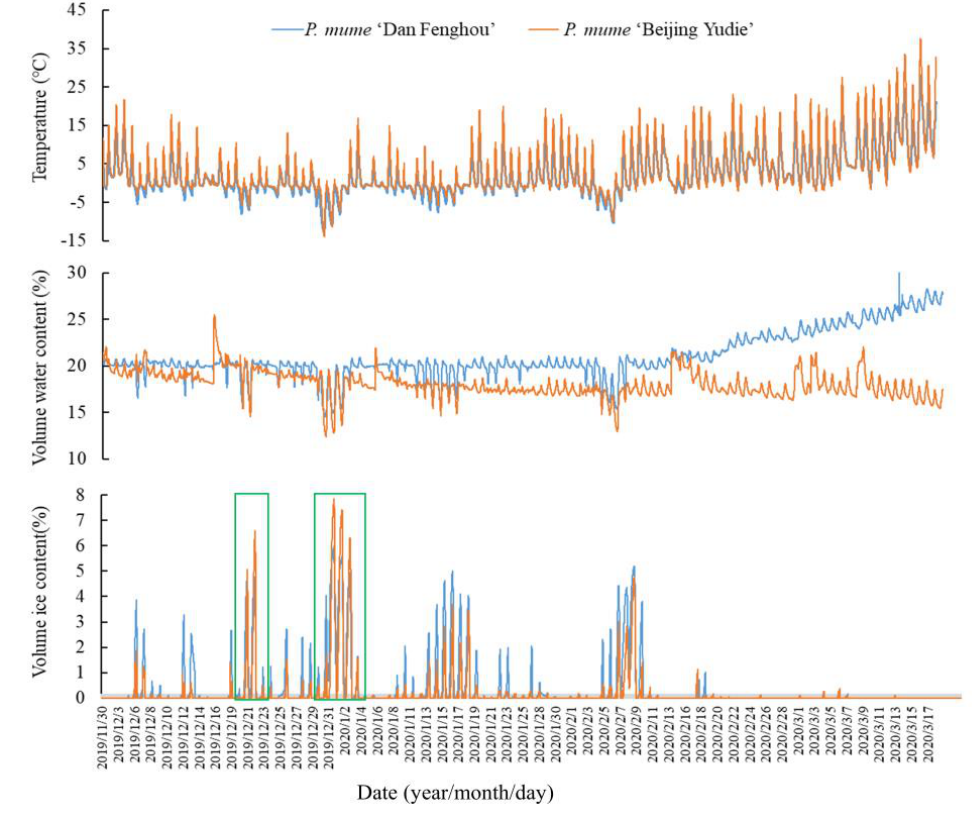
Figure 2. Dynamic monitoring of temperature, moisture content, and ice conditions during overwintering of adult trees of apricot mei DF and true mume BY.